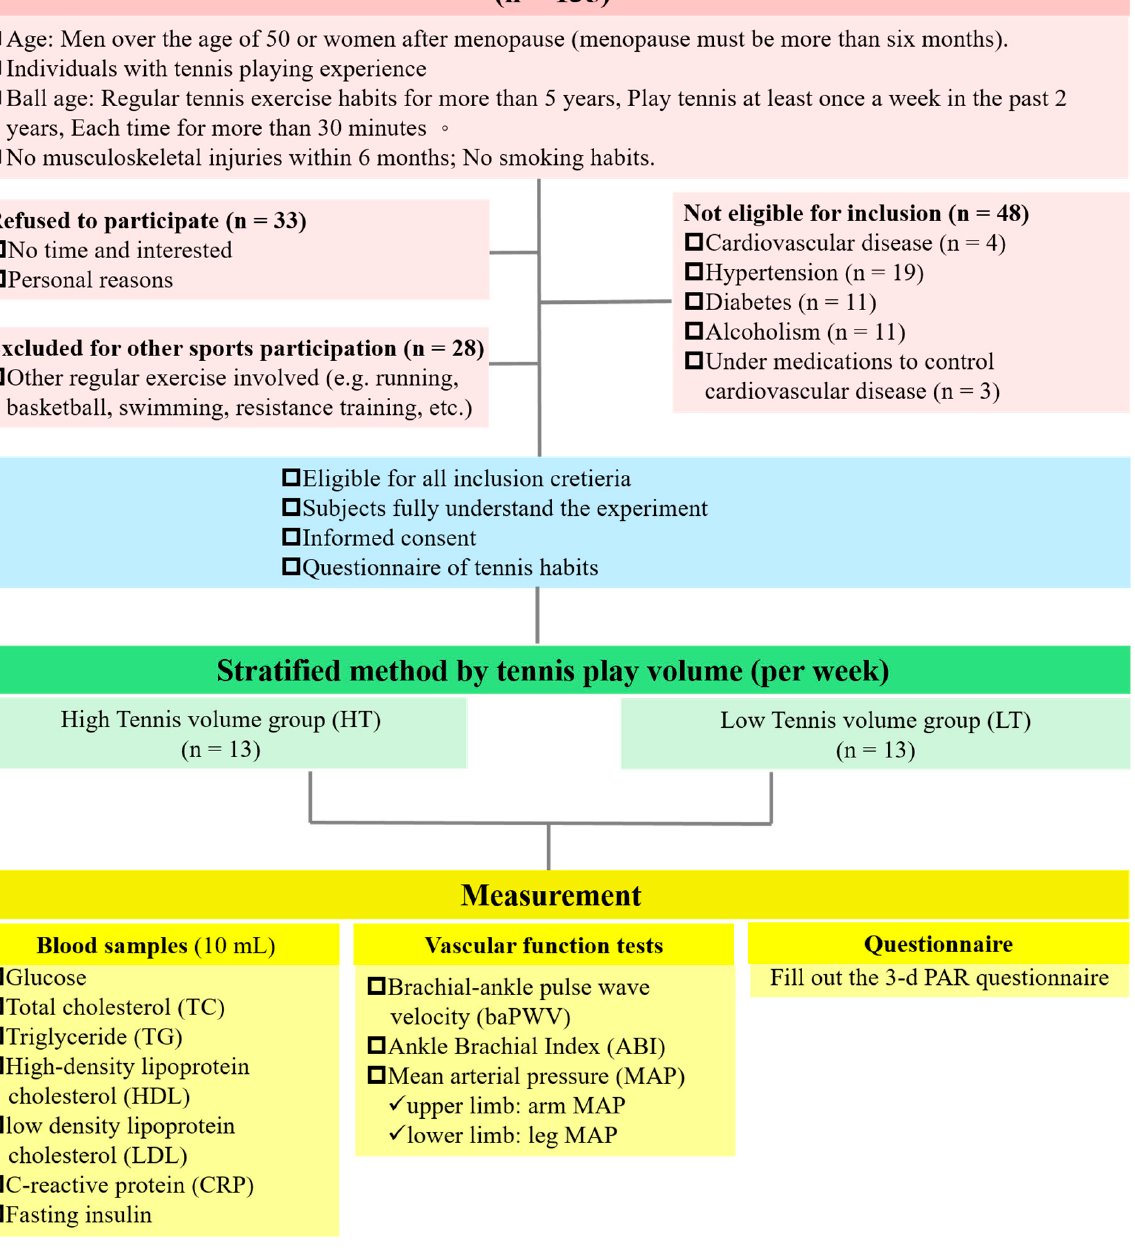
Figure 1. Flow chart of the study participant’s screening and recruitment over the study period.